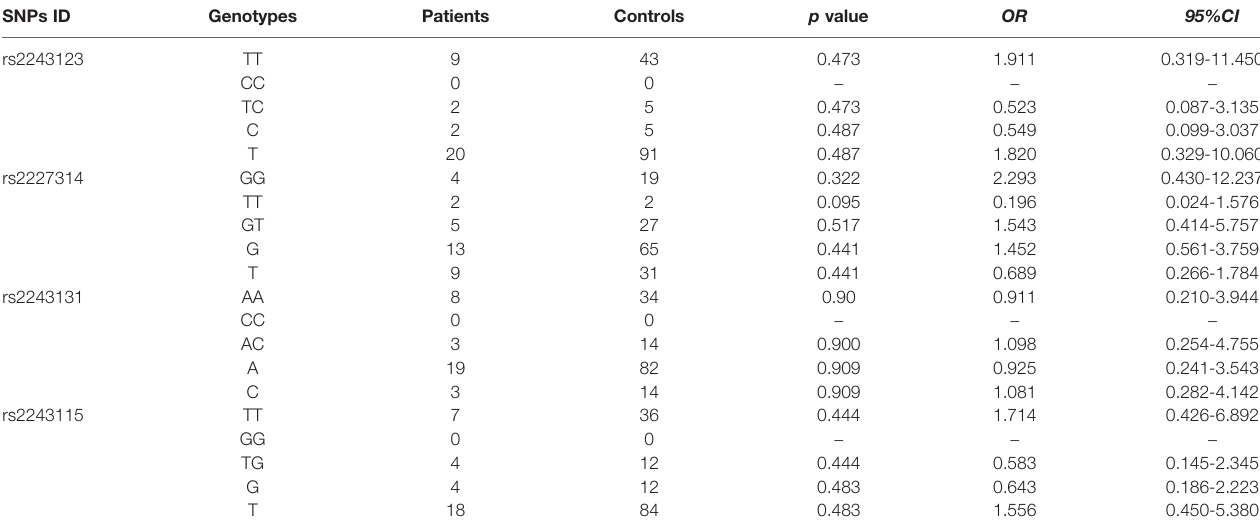
TABLE 1 | IL-12A genotypes and alleles frequencies of genotypes SNPs in BD and healthy controls. SNPs ID Genotypes